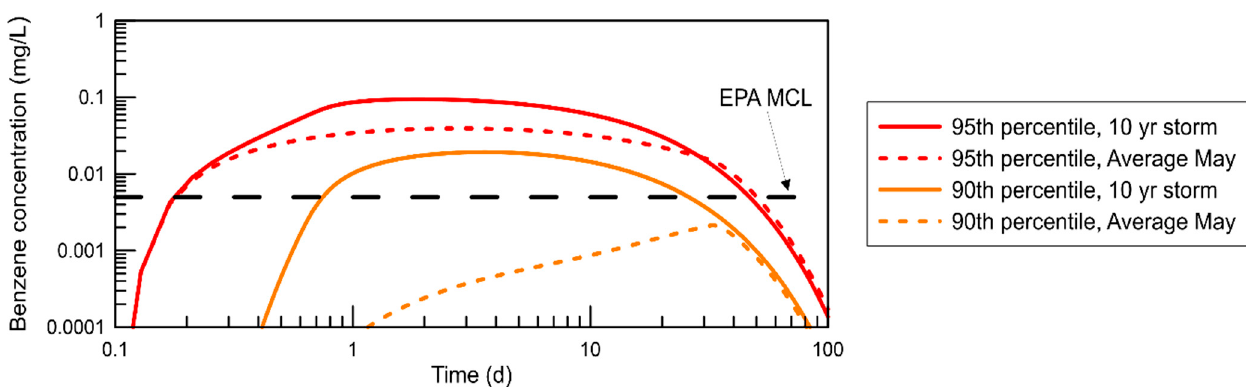
Figure 7. Benzene concentration breakthrough curves for a 2 ft water table considering sorption and degradation with precipitation events immediately following the spill on a log–log scale. This plot compares the 10 year storm to an average May, with the same total precipitation depth but different precipitation rates.